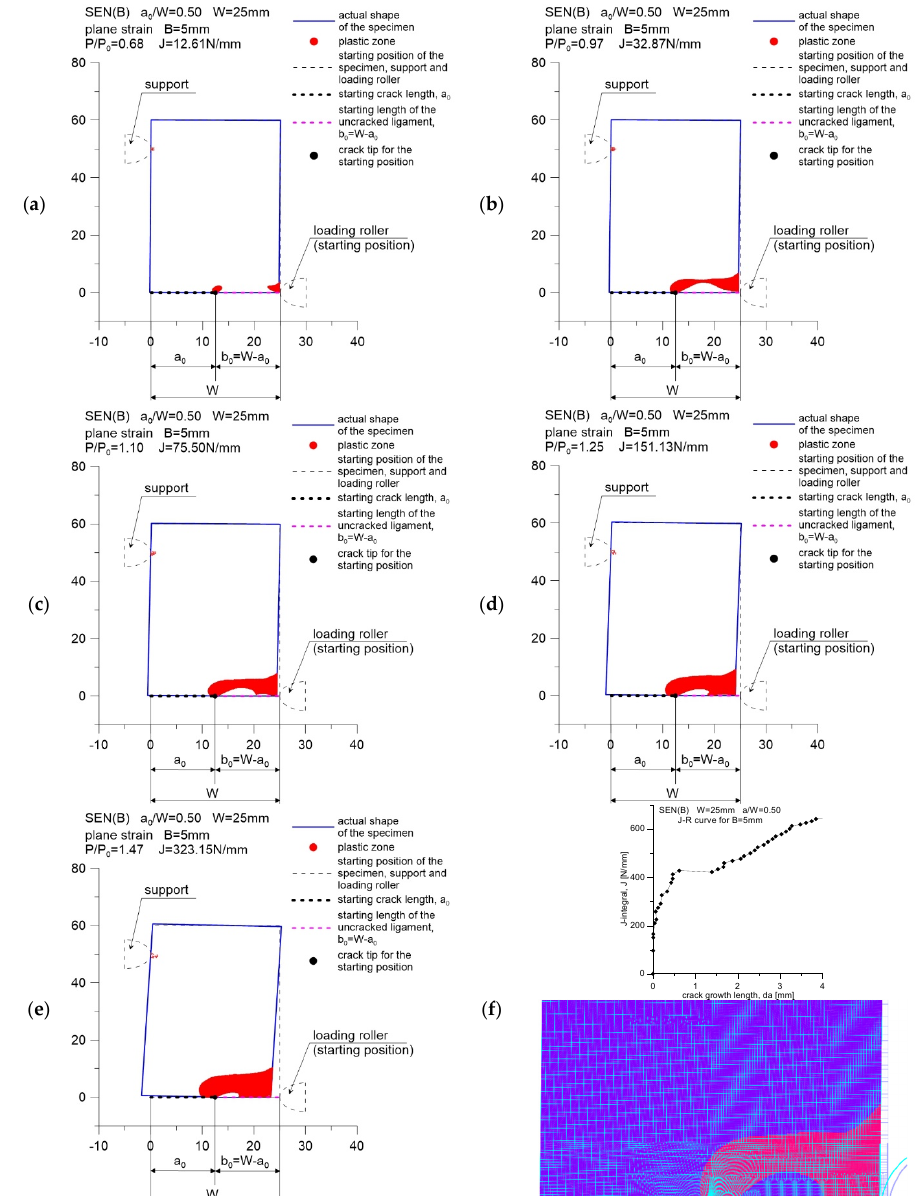
Figure 4. Change in the size of the plastic zone for the SEN(B) specimen, made of 41Cr4 steel, with a thickness of B = 5 mm. Specimen number in Table 1: 5.1: ( a ) results for P / P 0 = 0.68 and J -integral J = 12.61 N/m; ( b ) results for P / P 0 = 0.97 and J -integral J = 32.87 N/m; ( c ) results for P / P 0 = 1.10 and J -integral J = 75.50 N/m; ( d ) results for P / P 0 = 1.25 and J -integral J = 151.13 N/m; ( e ) results for P / P 0 = 1.47 and J -integral J = 323.15 N/m; ( f ) the J - R curve for specimen and the shape of plastic zone for last point from J-R